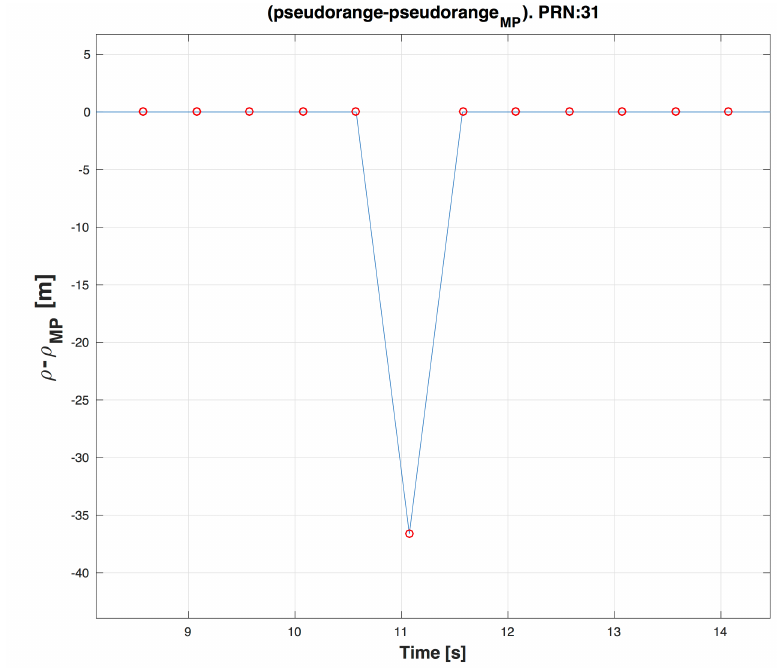
Figure 7. Zoom around 10 s of ρ clean − ρ MP in the case ∆ T ρ = 500 ms in blue and MP profile in